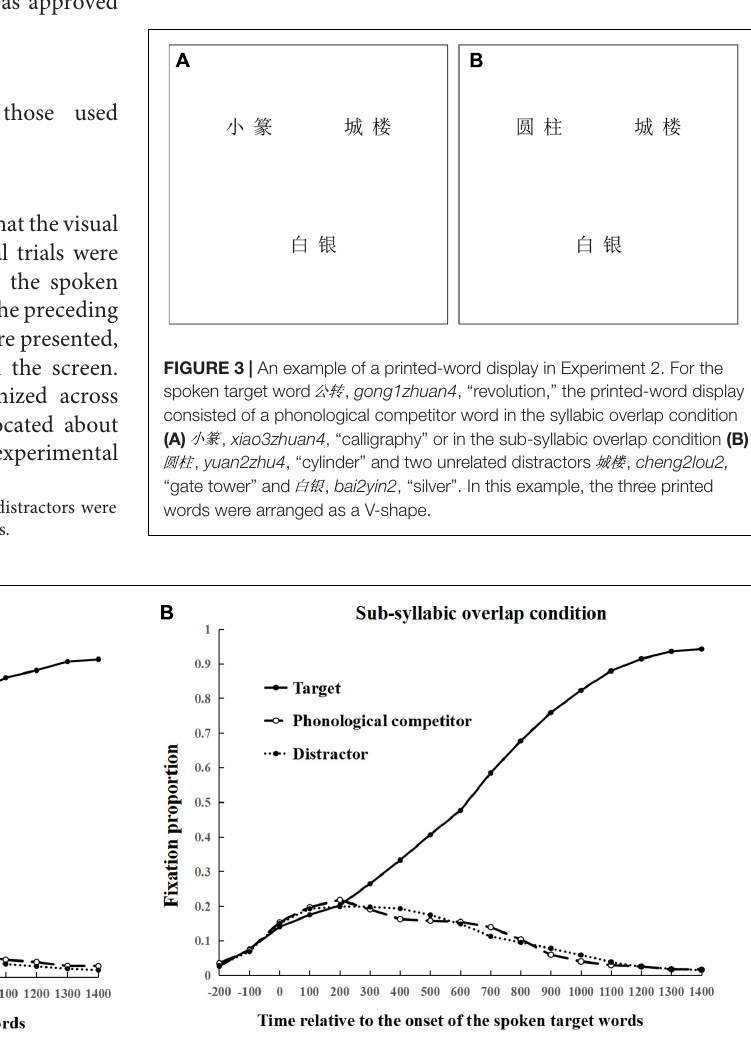
Frontiers in Psychology |